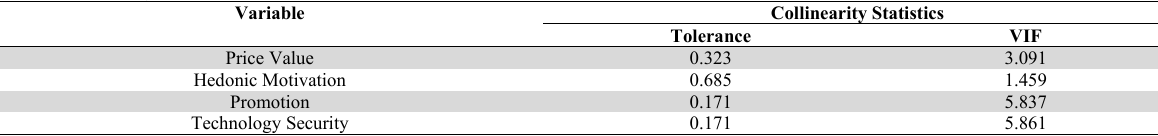
Multicollinearity Test